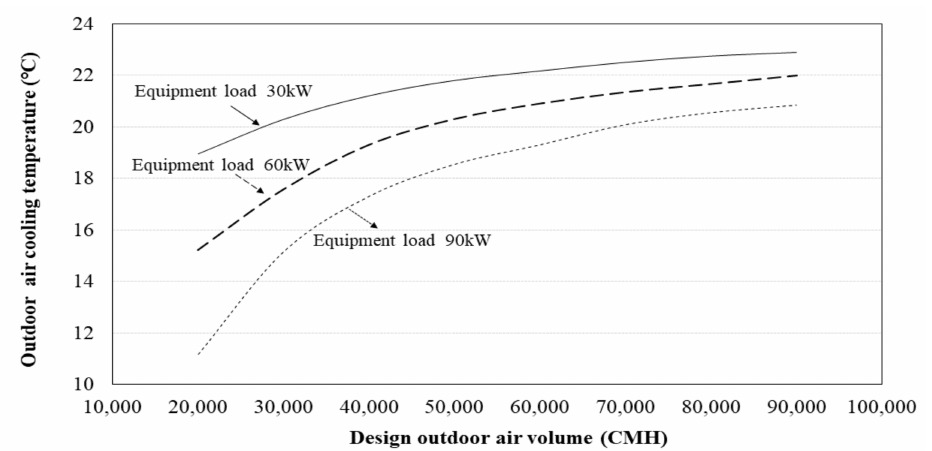
Figure 13. Outdoor air-cooling temperature according to the design outdoor air volume by equipment load.